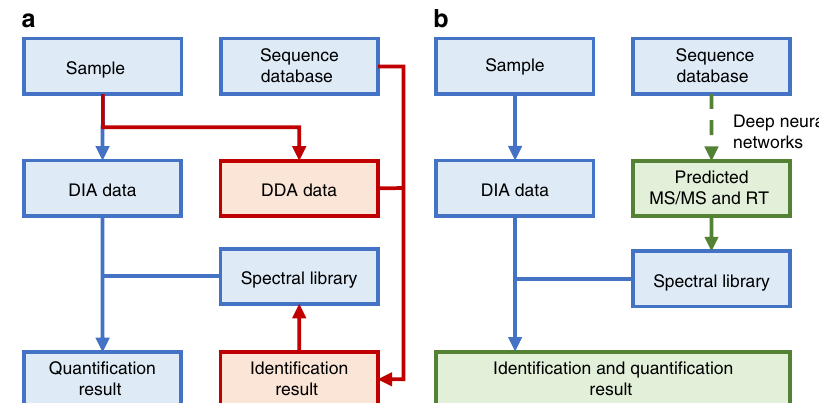
Fig. 1 The work fl ow of conventional DIA analysis and DeepDIA. a In conventional DIA analysis, DIA target extraction is performed using sample-speci fi c spectral libraries built with DDA result. b DeepDIA uses deep neural networks to generate in silico spectral libraries from protein or peptide sequence